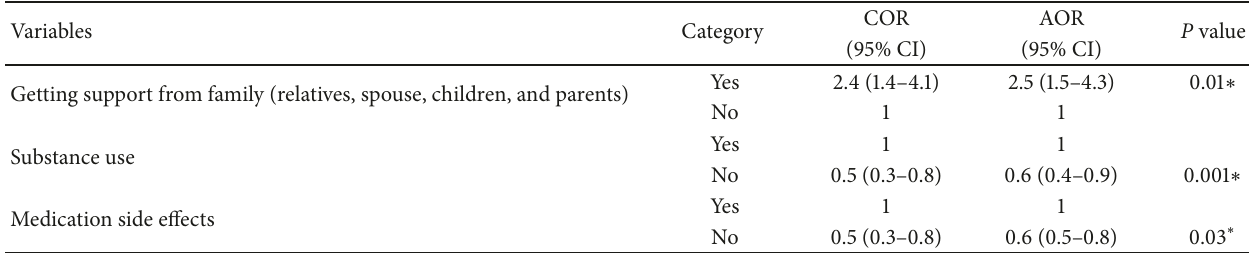
Regularly taking the ordered medication Medication side effects Traditional treatment use history